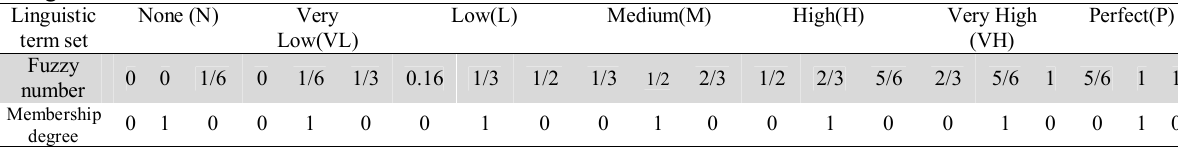
Linguistic interval